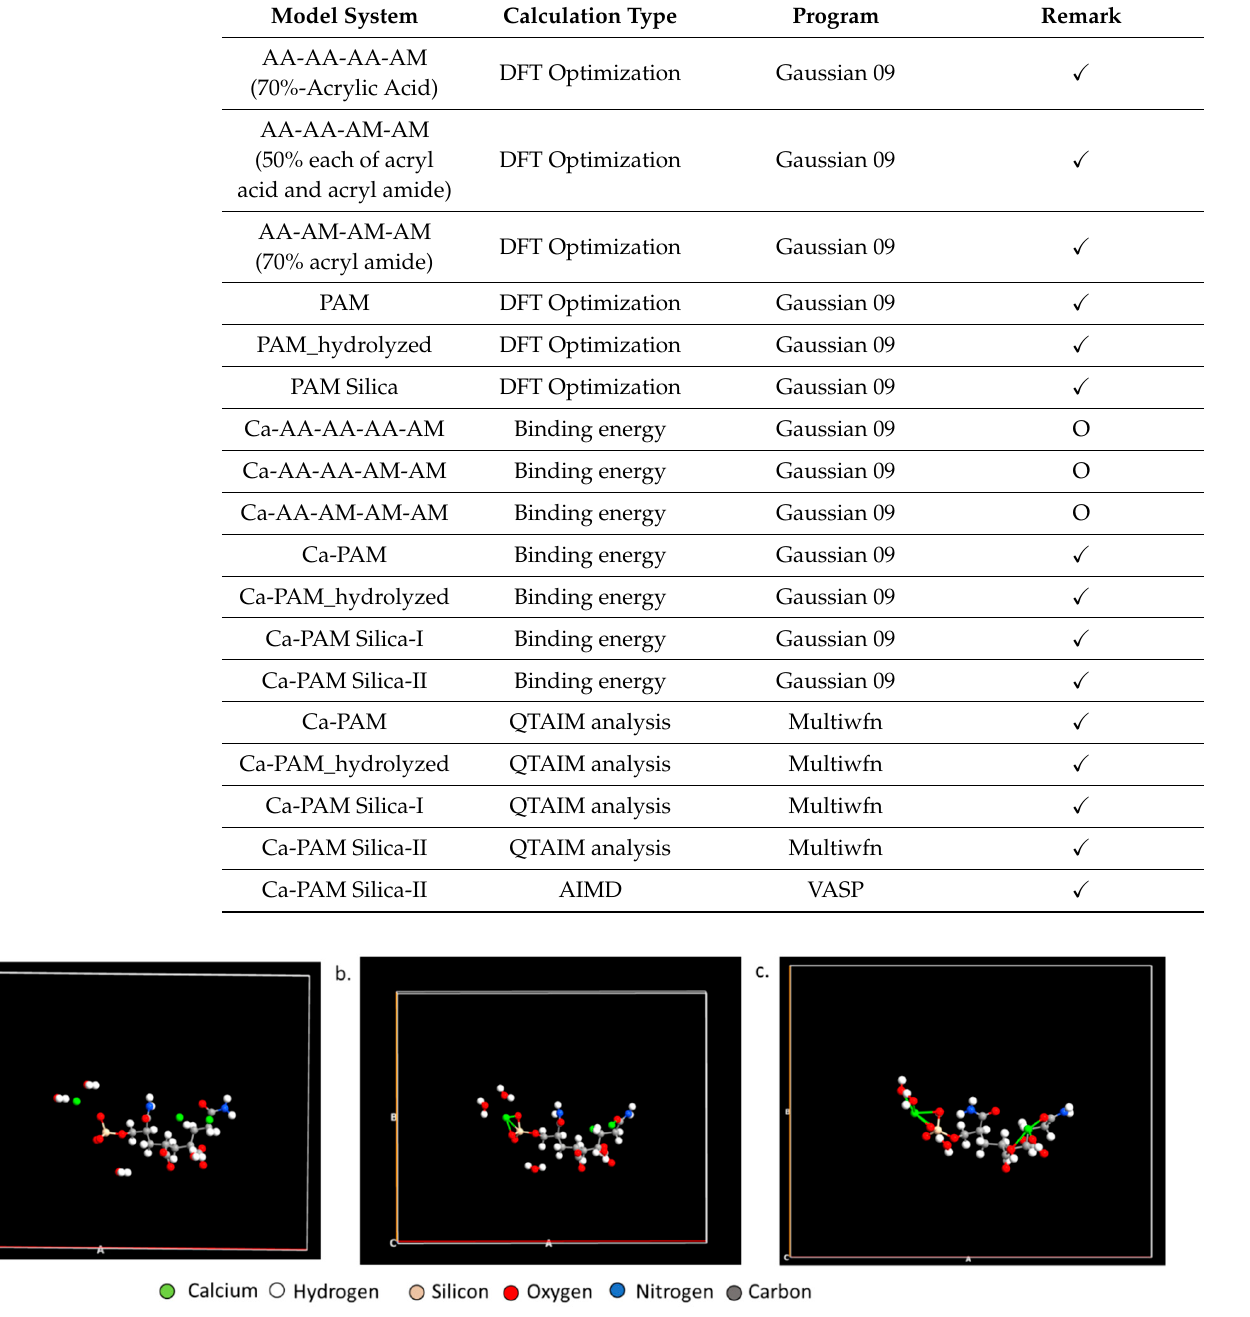
Figure 9. The ( a ) initial, ( b ) middle, and ( c ) final position of the molecular dynamics trajectory of PAM-Silica with Ca 2+ ions and water molecules.